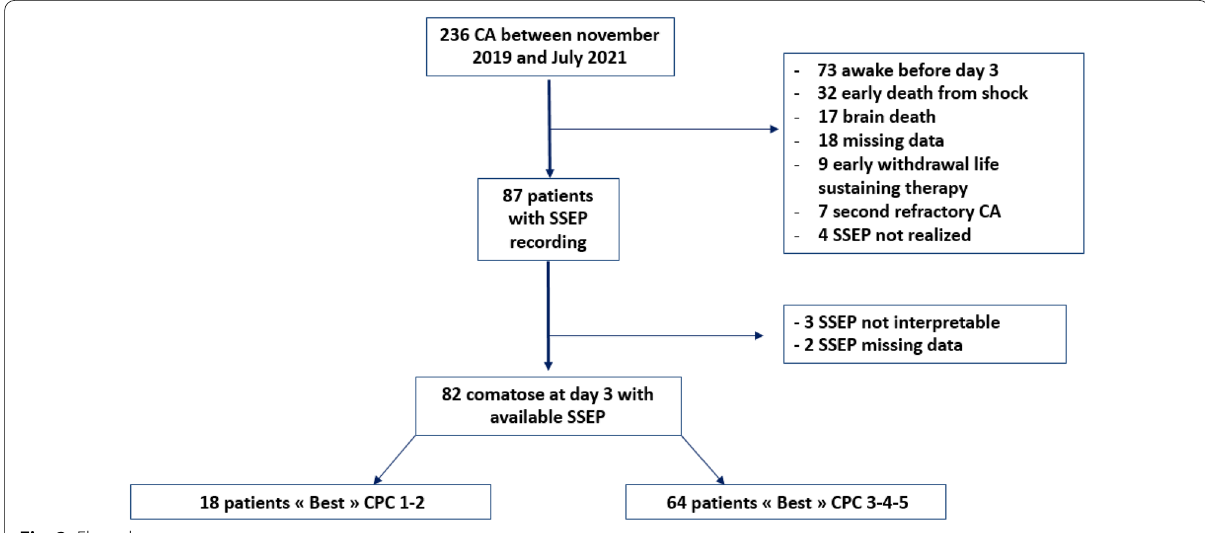
Fig. 2 Flow chart